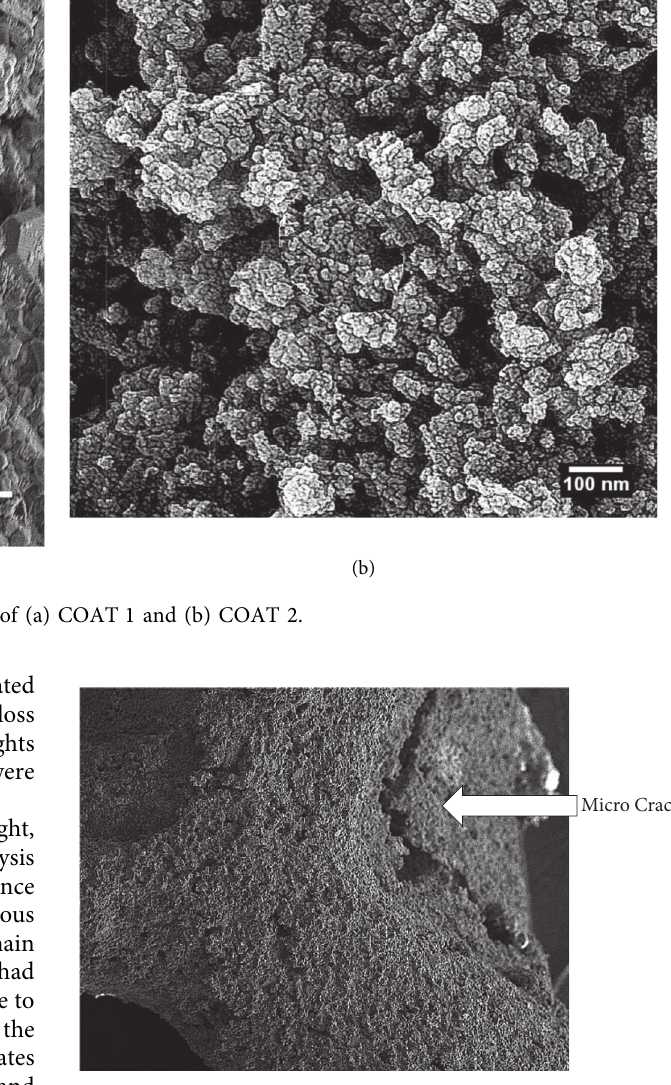
Figure 10: Microcracks in COAT